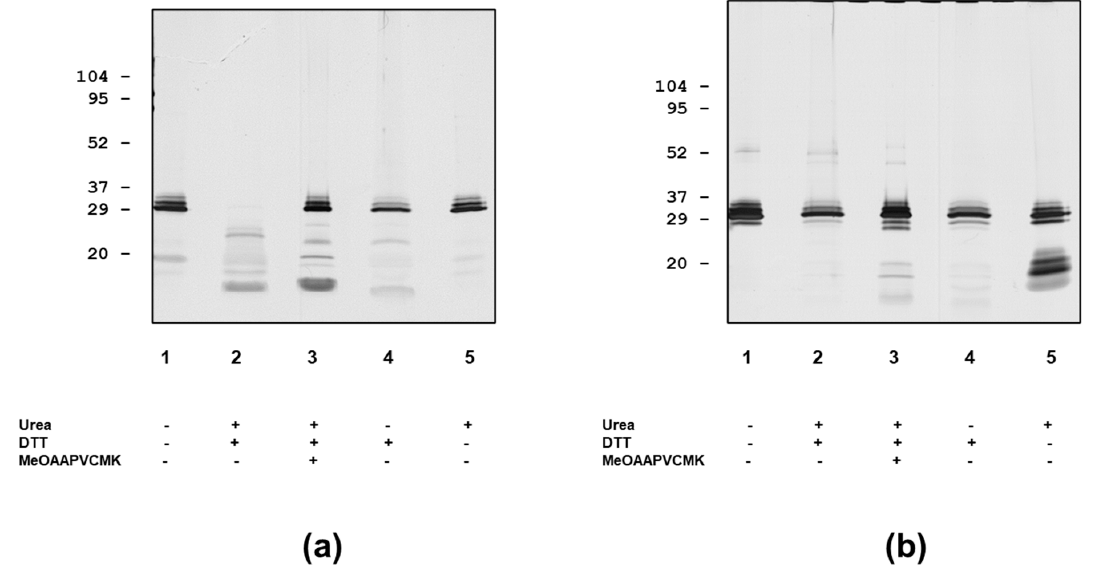
Figure 5. Composition and autoproteolytic activity of PR3 preparations and effect of pre-treatment